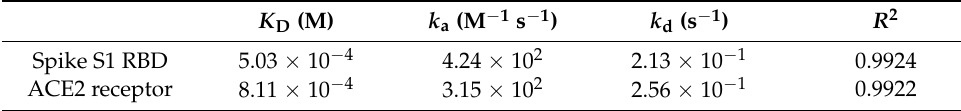
Figure 2. The global kinetic analysis of KC binding to biotinylated ( A ) spike S1 RBD- and ( B ) ACE2 receptor-immobilized BLI sensors. The kinetics for the binding of KC to the spike S1 RBD or the ACE2 receptor were measured by the association of 0, 50, 200, and 400 µM of KC in PBS containing 1% DMSO with immobilized spike S1 or ACE2 receptor and the subsequent dissociation in PBS containing 1% DMSO. Table 1. The binding kinetics of KC to spike S1 RBD and ACE2 receptor.